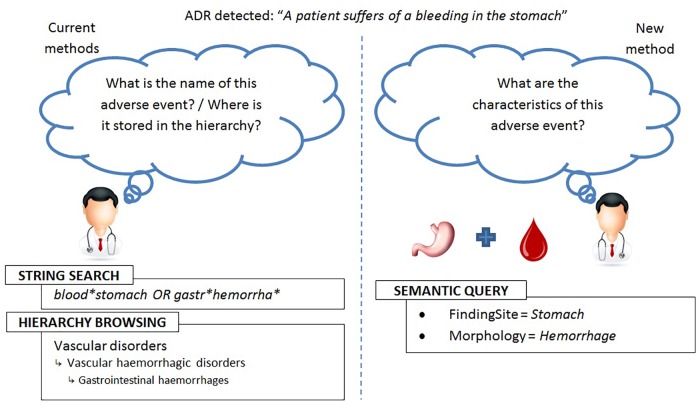
Comparison between string search and hierarchical browsing (left) with semantic queries (right).